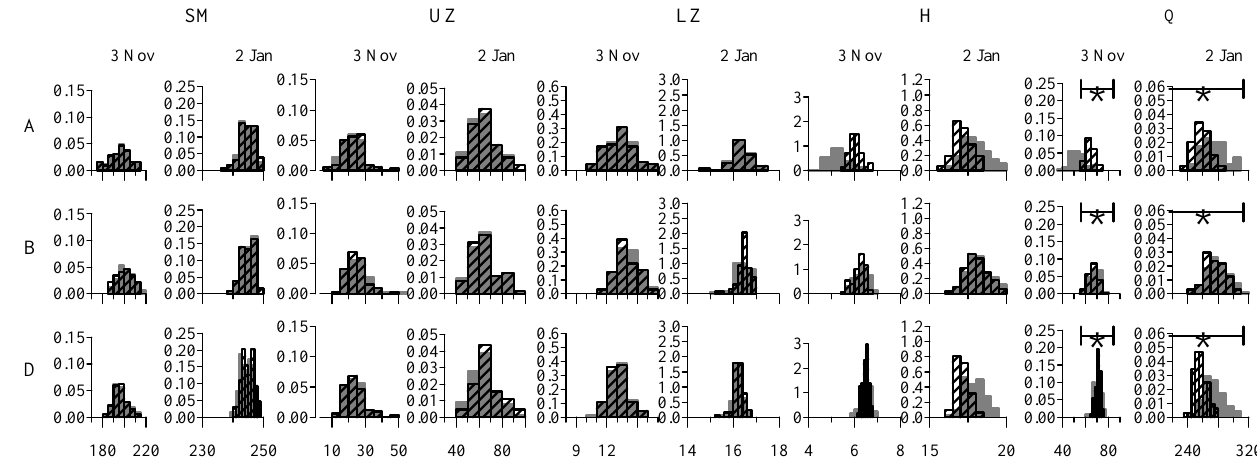
Fig. 10. Real world experiment. Forecasted (grey histograms) and analysed (dashed histograms) model states at location 1 for two dates (3 November and 2 January) and considering 3 discharge observation vectors (A, B, D). The true states are indicated by asterisks and the error bars represent the 95% confidence bounds of the observation errors ( ν k in Eq. 13).